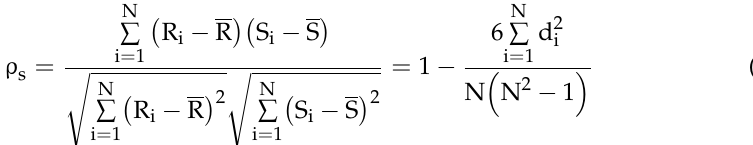
Figure 3. Wind power and impact factor data curves in one day.